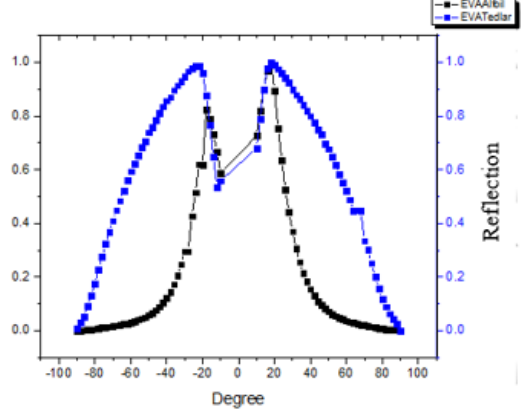
Figure 6. Average reflection from ARTA for both types of module having EVA.